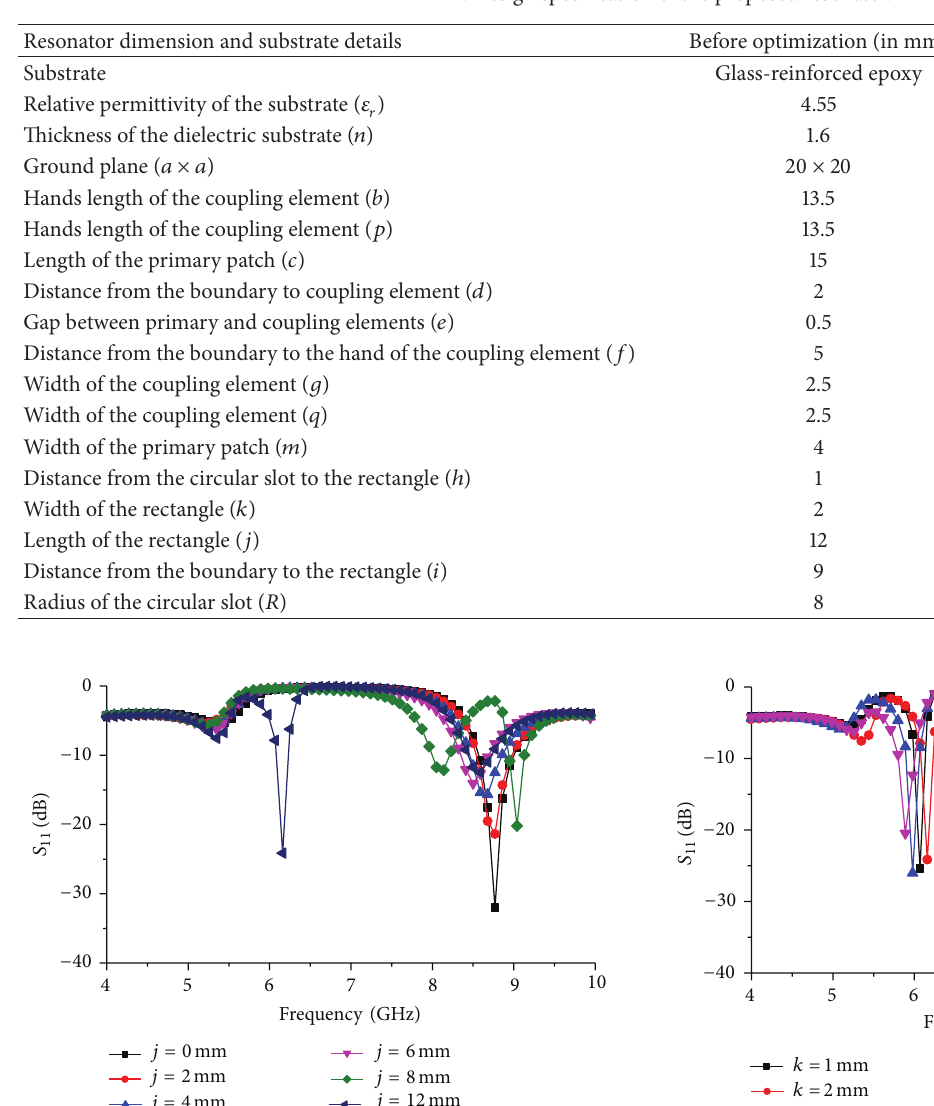
Table 2: Design specification of the proposed resonator.